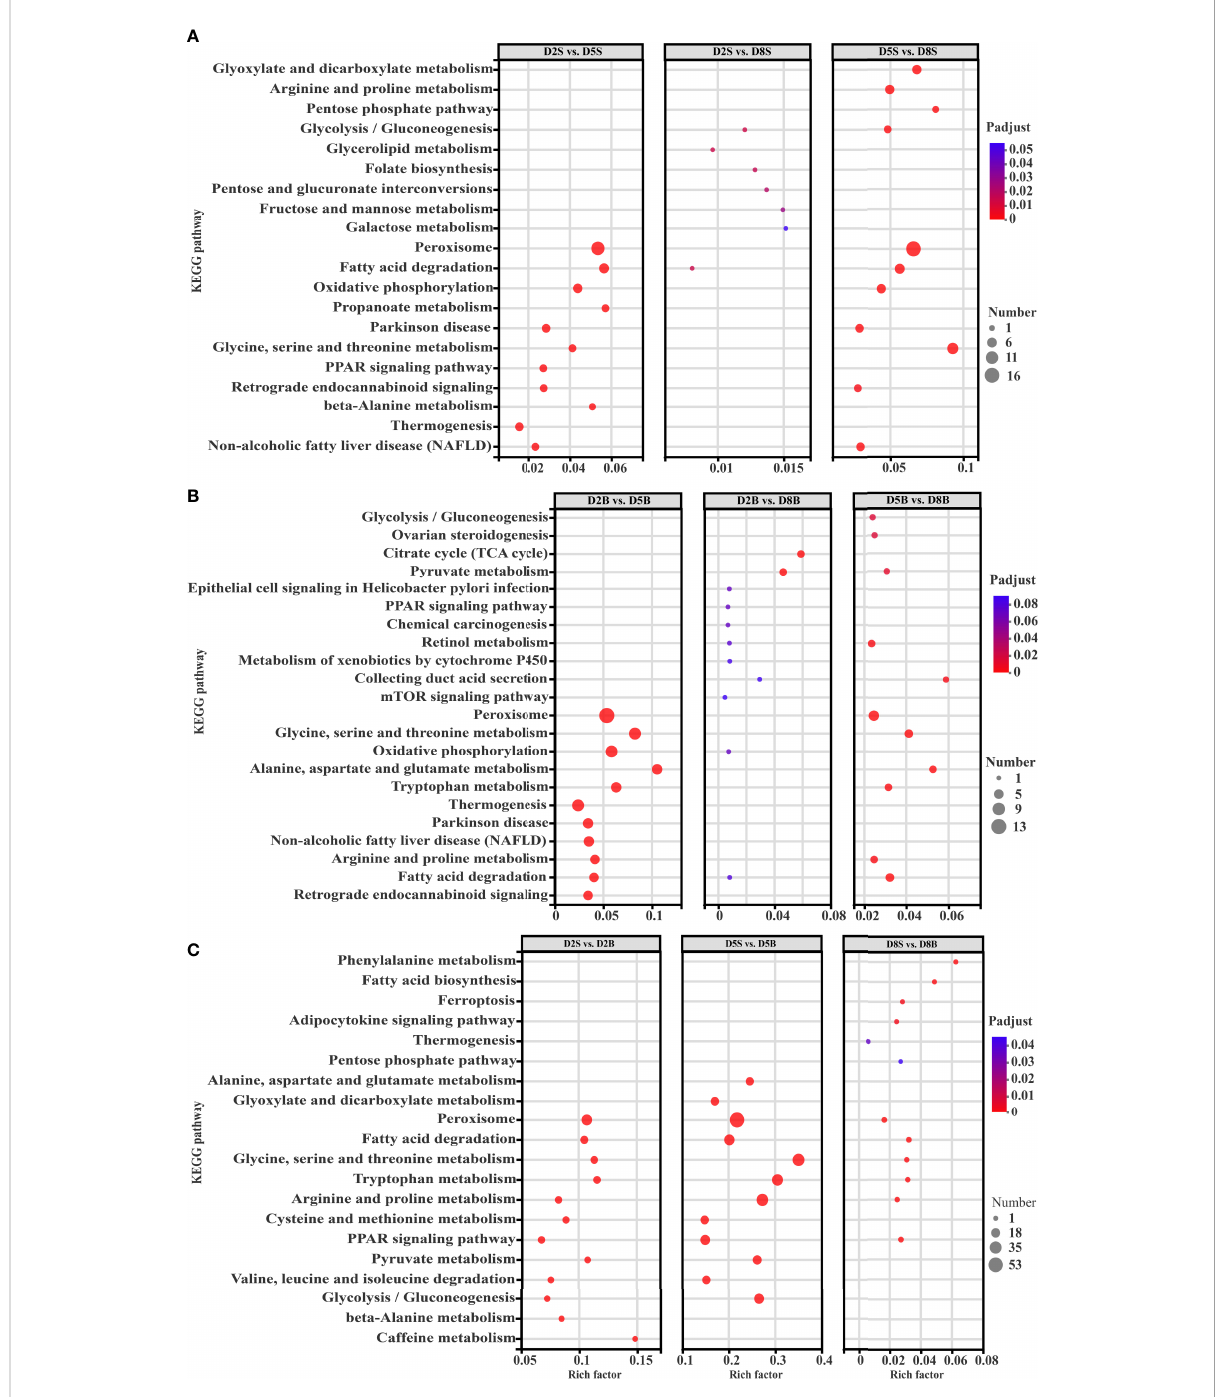
FIGURE 3 KEGG enrichment of differentially expressed genes (DEGs) in the respiratory tree and body wall at different stocking densities. (A) Enriched KEGG pathways of DEGs in the respiratory tree among different stocking densities; (B) Enriched KEGG pathways of DEGs in the body wall among different stocking densities; (C) Enriched KEGG pathways of DEGs between the respiratory tree and body wall at the same stocking